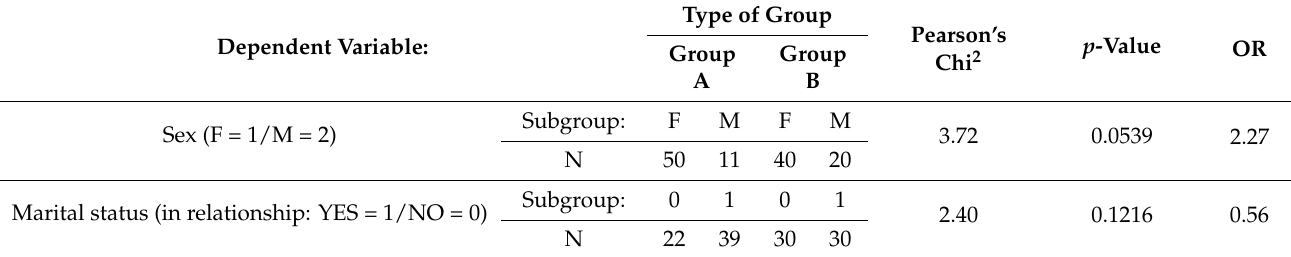
Table 1. Baseline characteristics for both groups.